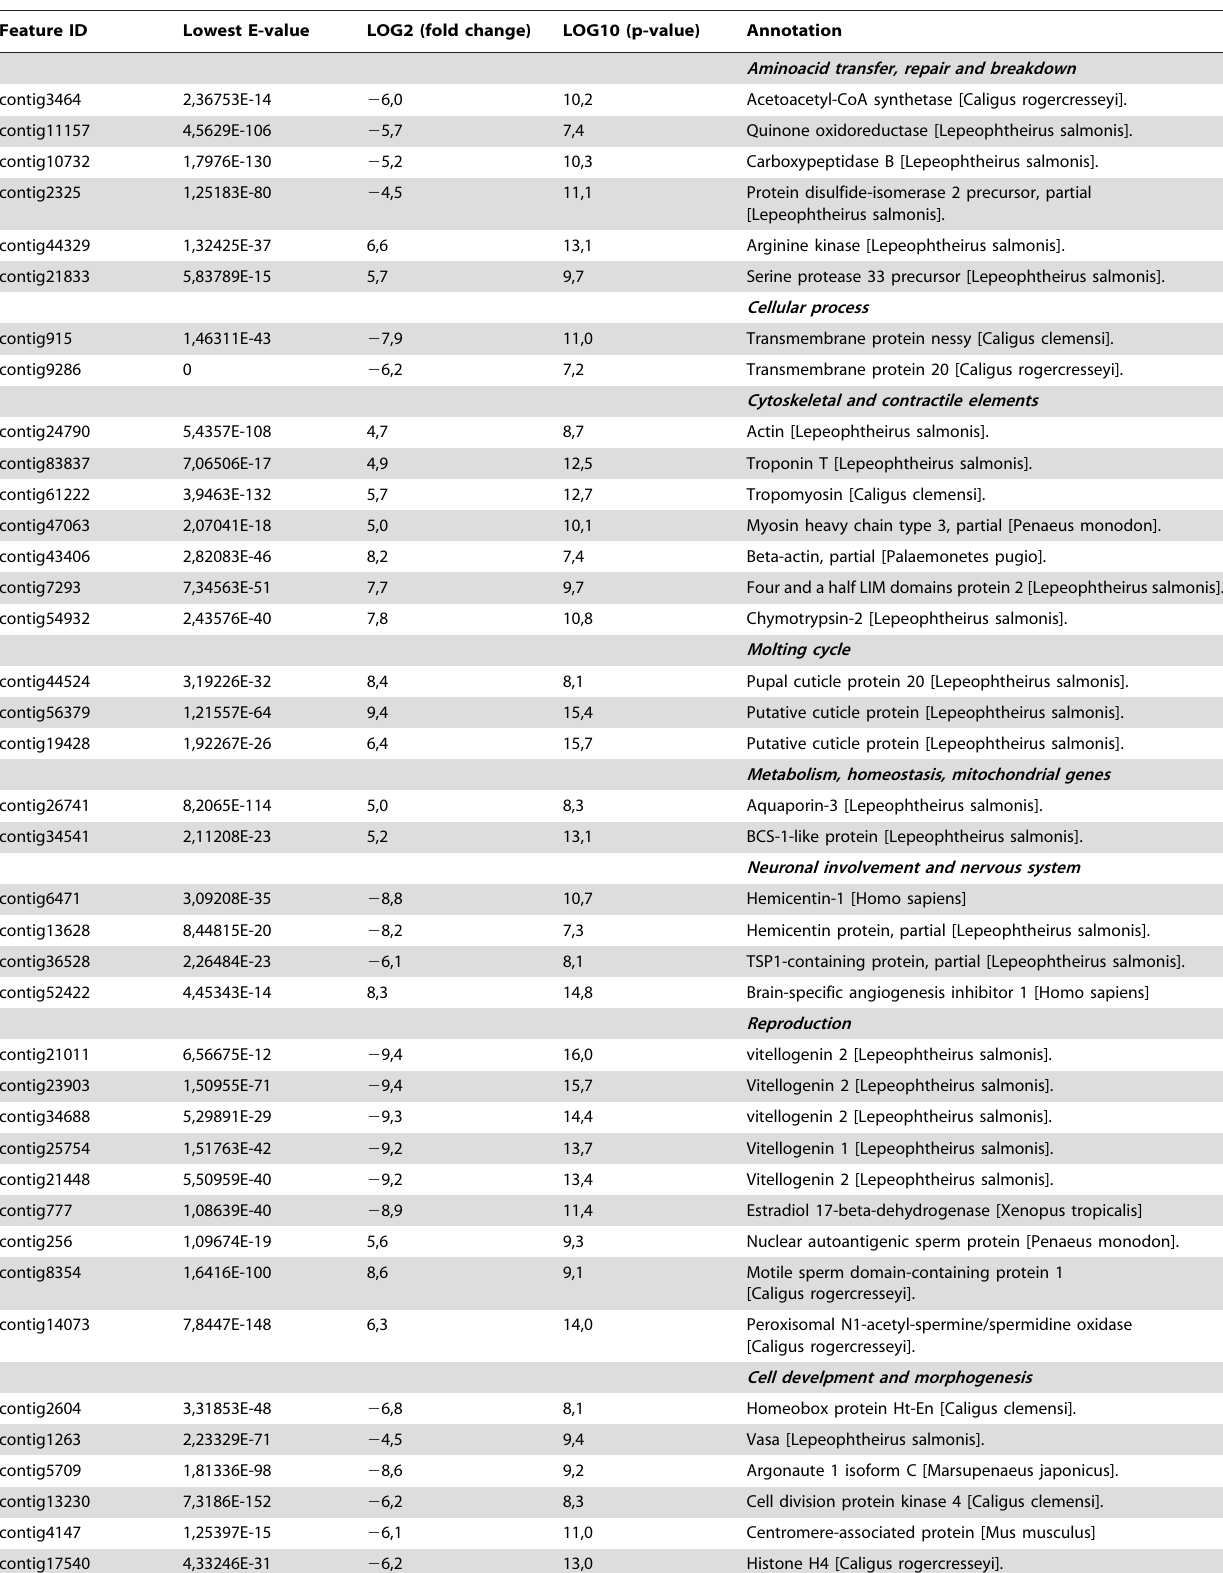
Table 5. Genes showing differential transcription expression between Male/Female groups.